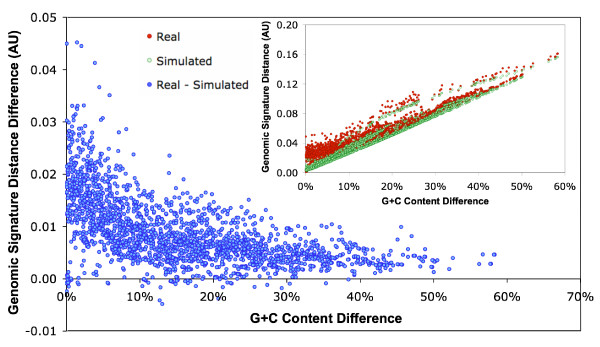
Difference in genomic signature distance between real and randomized data for all possible pairs of 67 LDVs. The inset figure shows the genomic signature distances between all possible pairs of 67 LDVs for both real and randomized data.